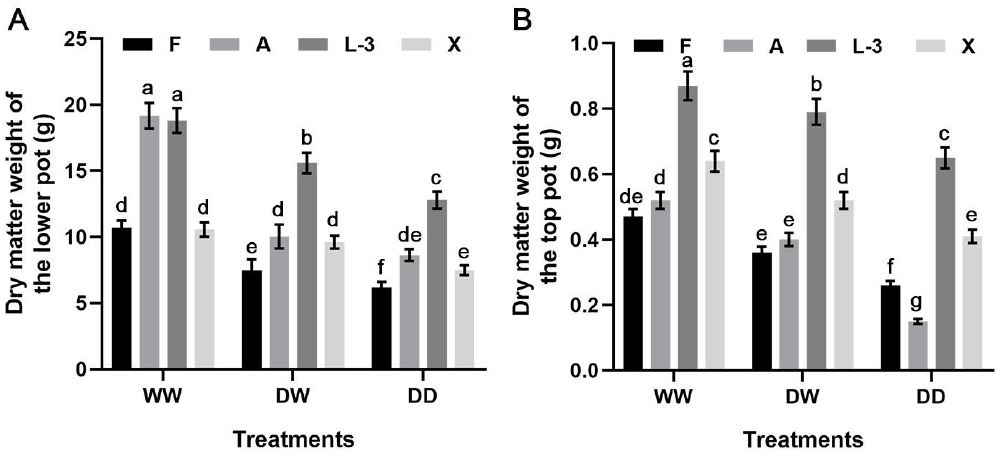
Figure 6. Dry matter weight of four potato cultivars ’ roots under different conditions. ( A ), dry matter weight of the lower pot. ( B ), dry matter weight of the top pot. WW, irrigation condition.